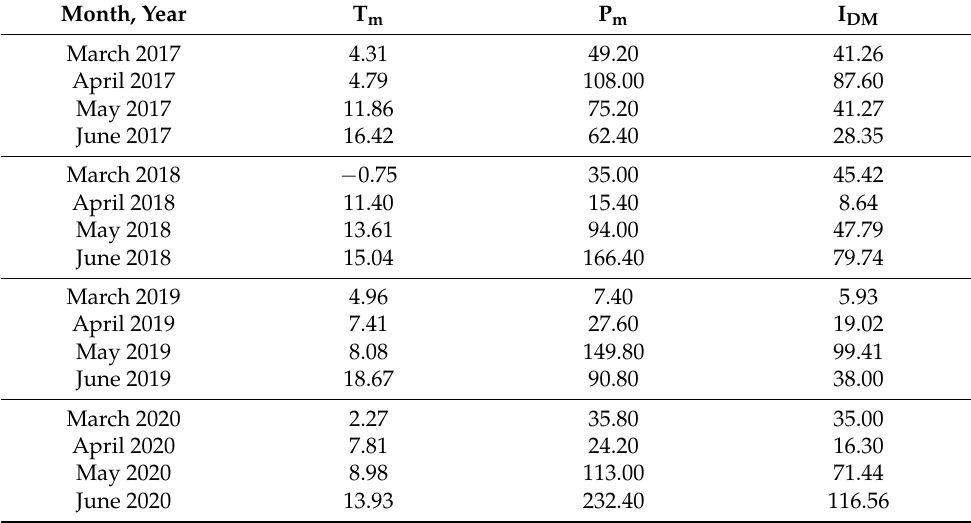
Table A3. Mean monthly temperatures (T m ), mean monthly precipitation (P m ) and aridity indexes (I DM ) in the months of sampling (April, June) and in the previous month from period 2017–2020. Data were obtained from the field climatic station in